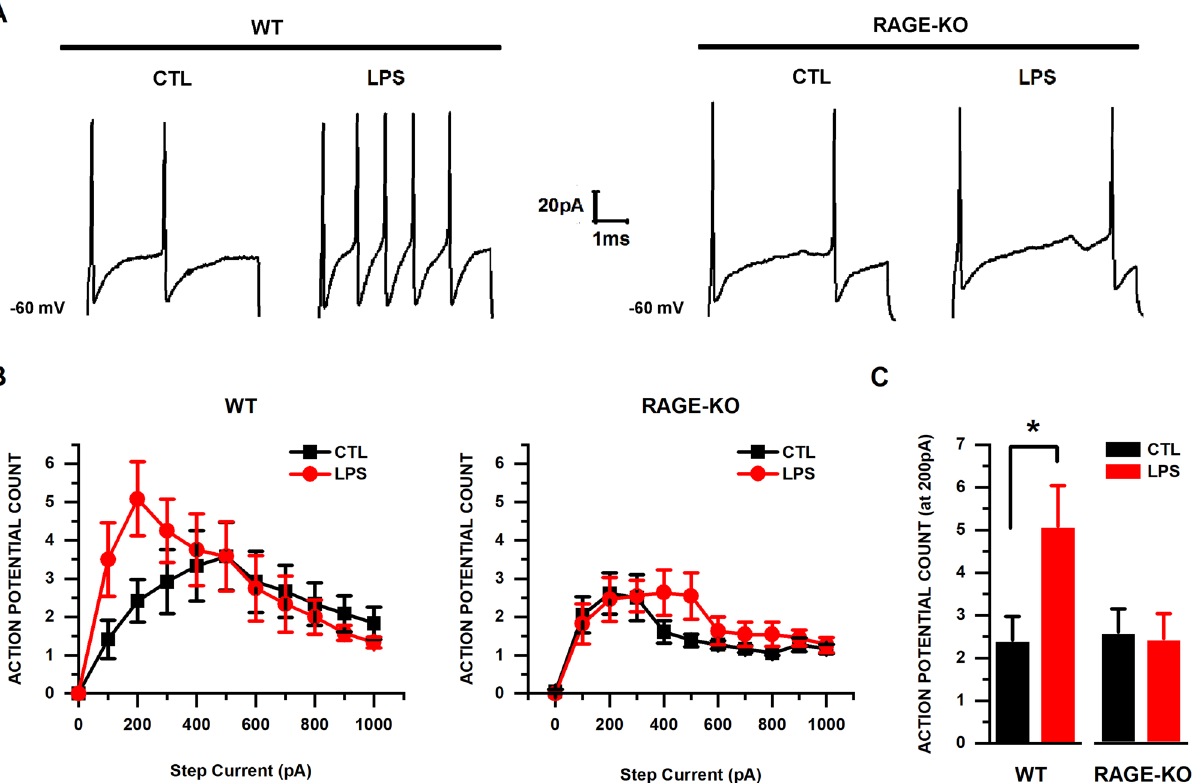
Figure 3. LPS exposure increases cell excitability in tDRG neurons from WT mice, but not from RAGE KO mice. ( A ) Representative action potential traces in response to the injection of a depolarizing current step (200 pA) in tDRG. ( B ) Mean action potential counts from cultured neurons from both genotypes. ( C ) Mean action potential count at the 200 pA current injection step. Treatment groups: WT control (n = 12); WT LPS (n = 12); RAGE KO control (n = 16); RAGE KO LPS (n = 11). Data presented as mean ± SEM. Means were statistically compared by 2-way ANOVA, followed by Tukey’s multiple comparison test; *p < 0.05.